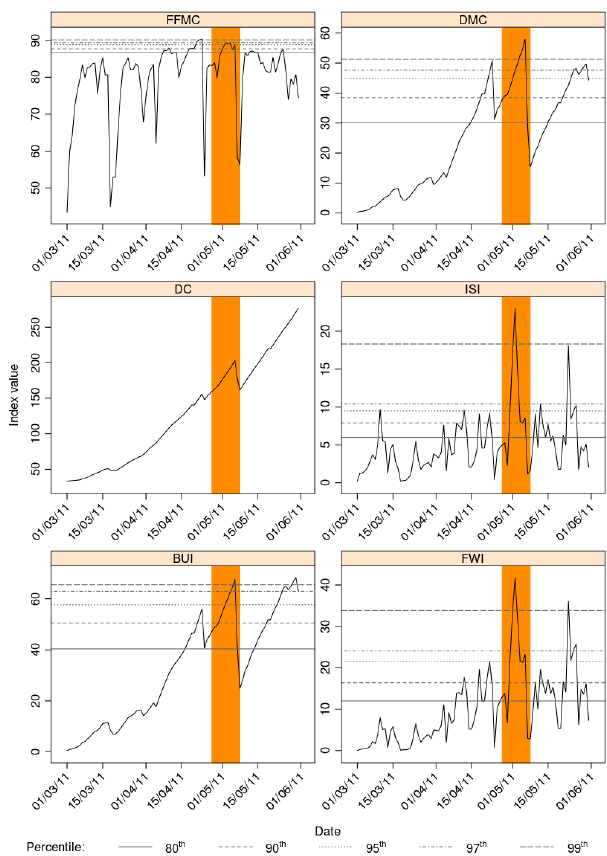
Figure 6. Temporal evolution of the FWI components at the loca- tion of the Swinley Forest wildfire that occurred in Berkshire, Eng- land, in April/May 2011. This fire was one of the most extreme fire events in the UK for many years, and it burned for 13 days accord- ing to the Incident Recording System database (timing indicated by the orange bars). Peak fire activity occurred on 2 May, and extreme behaviour persisted until 6 May (Kitchen, 2012). Horizontal dashed lines indicate the 80th, 90th, 95th, 97th and 99th percentiles of each FWI component for this particular UK grid cell during the spring season, calculated according to the criteria described in Sect. 4.1. The ISI and FWI components in particular have extreme maxima during this fire, with the high ISI values highlighting the importance of wind speed for this